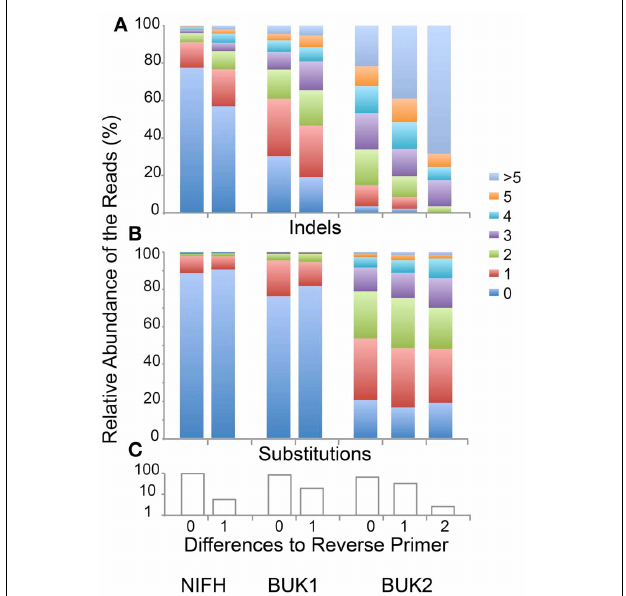
FIGURE 3 | Indels and substitutions varying by differences to reverse primer. (A) Fraction of reads with the given number of indels for each reverse primer difference. (B) Fraction of reads with the given numbers of substitutions for each reverse primer difference. (C) Fraction of total reads with exactly the specified number of differences to the reverse primer. Eight BUK1, 57 BUK2, and no NIFH reads had two primer differences (NIFH and BUK1 with two differences were not shown).